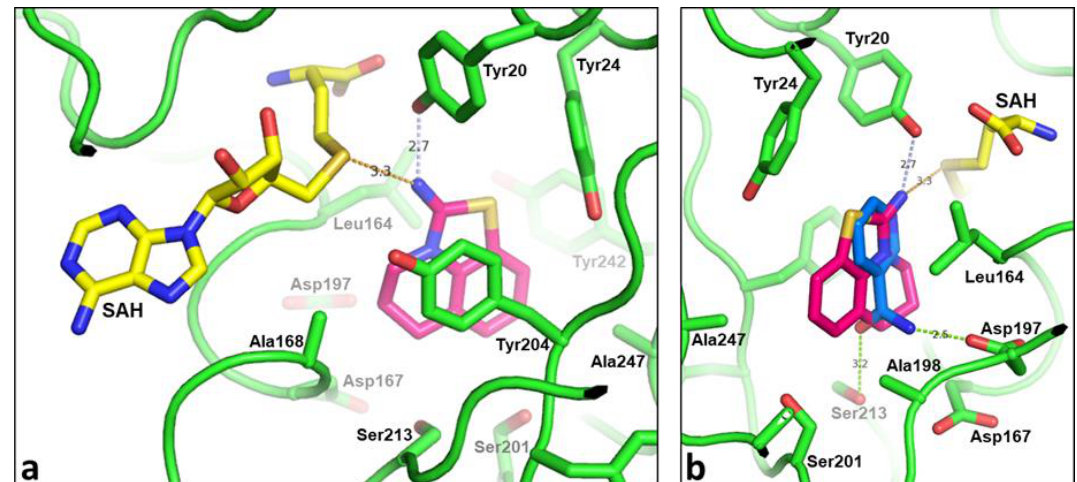
Figure 4. ( a ) Crystal structure showing the interactions of inhibitor ( 2 ) with hNNMT. Inhibitor ( 2 ) is shown in purple, S -adenosyl-homocysteine (SAH) in yellow, and hNNMT in green. ( b ) Comparison of the binding mode of nicotinamide (blue; pdb entry 3rod [4]) and inhibitor ( 2 ) (purple; this study), as well as a ribbon presentation of the NNMT protein from the inhibitor ( 2 ) complex (green).